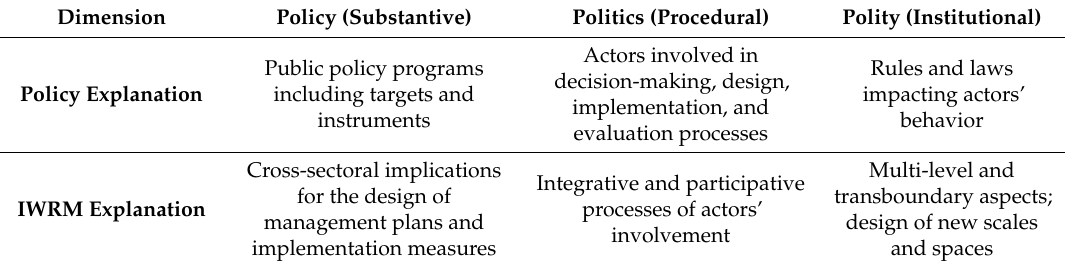
Table 1. Policy Analysis of Integrated Water Resources Management